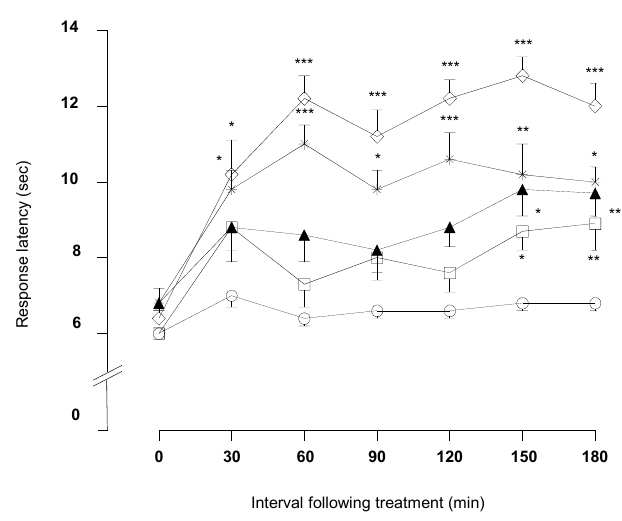
Figure 4. Effect of DMFP on the hot plate test in mice. Results are expressed in mean ± S.E.M. of response latency (s) of 6 mice. Statistical significance was denoted by one-way ANOVA followed by Dunnett’s post-hoc test. * p < 0.05; ** p < 0.01; *** p < 0.001 compared with control group; Control (